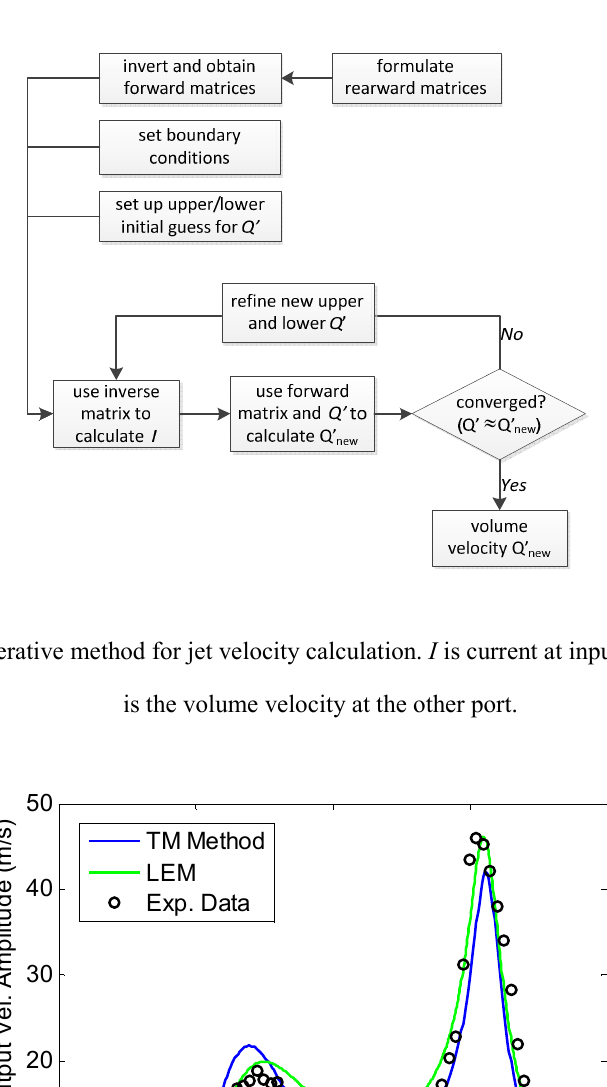
Fig. 14 Comparison of TM, LEM and experimental data of jet velocity for a synthetic-jet actuator with bottom-mounted PZT disc (Case I